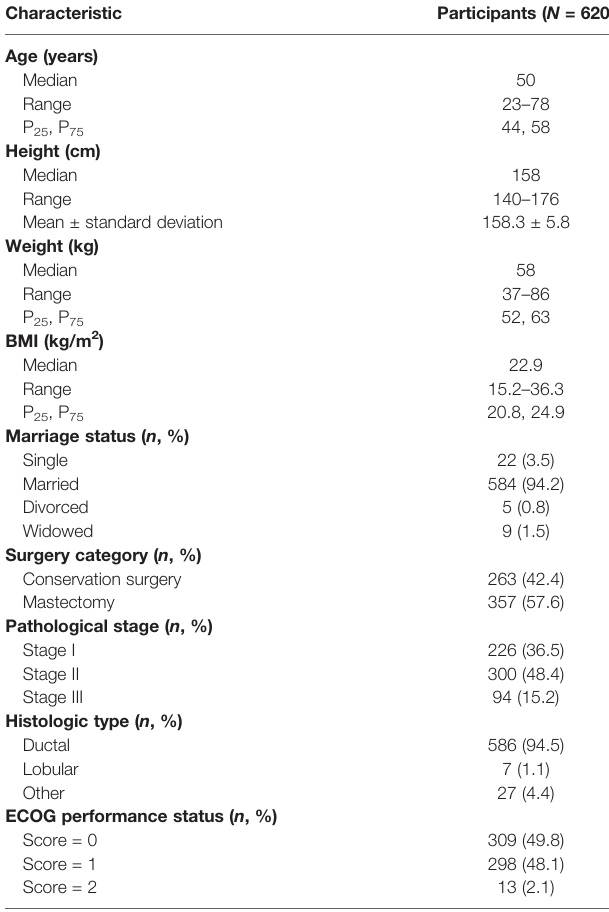
TABLE 1 | Participant